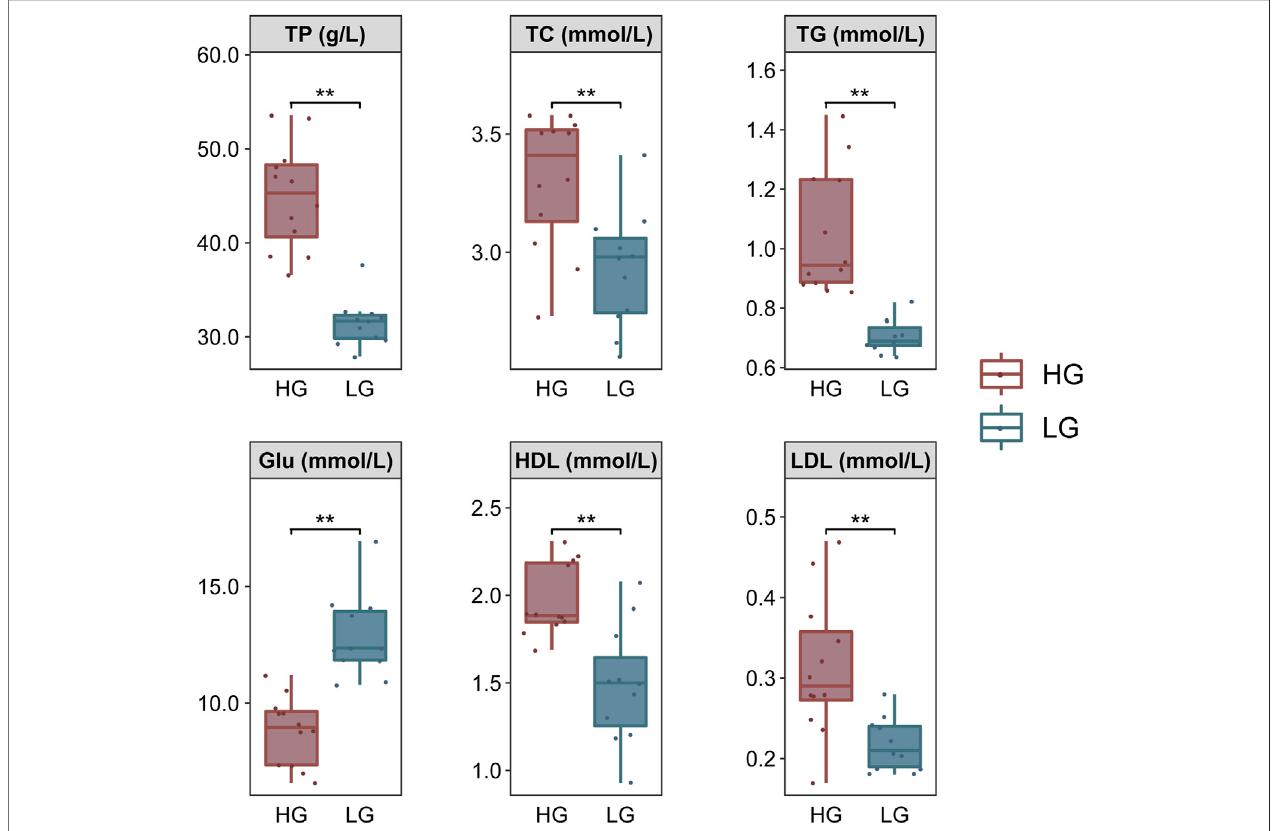
FIGURE2| ComparisonofbiochemicalparametersofNiletilapia,groupedaccordingtoextremegrowthdifferences( n =12).Levene ’ stestwasusedtoassessthe equality of variances in the data, and the independent samples t -test showed a normal distribution ( p > 0.05). ** p < 0.01.